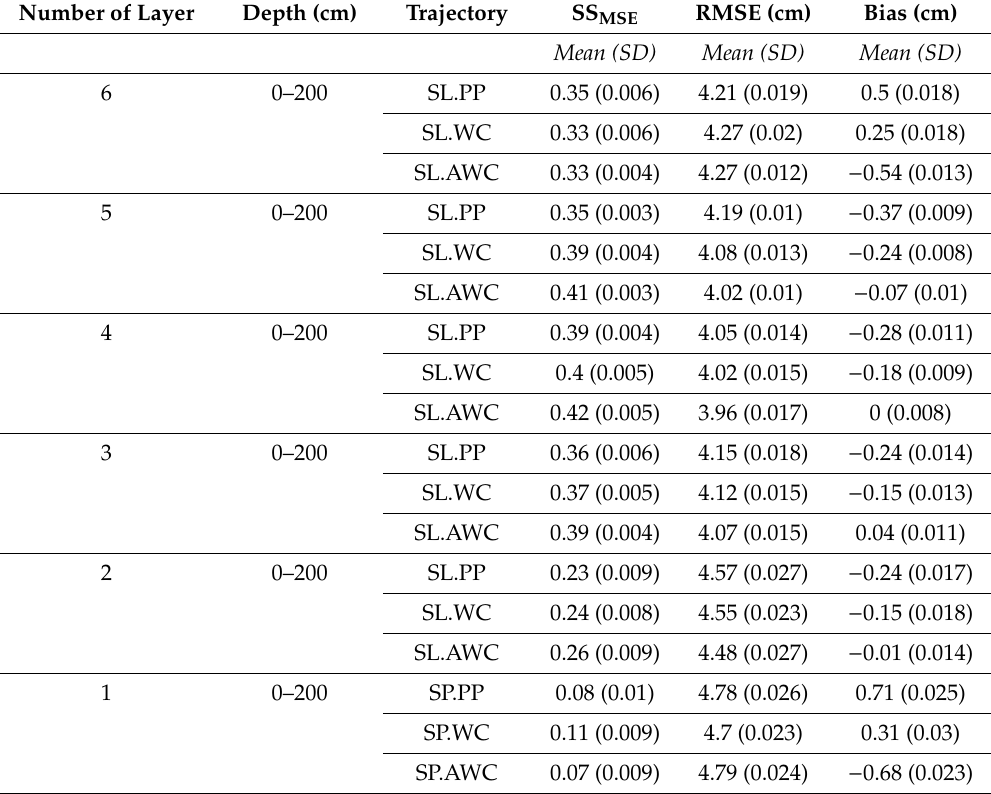
Table 9. Averaged values of performance indicators SS MSE , root mean square error (RMSE), and Bias, and their corresponding standard deviation